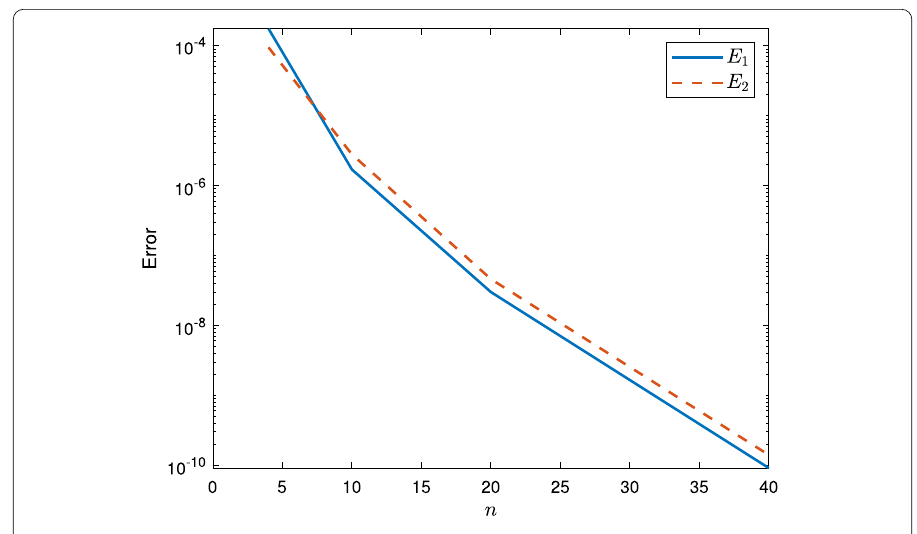
Figure 2 The log-plot of errors for Example 1 with w 1 = 1 + x , w 2 = 0.1 + sin( π x )